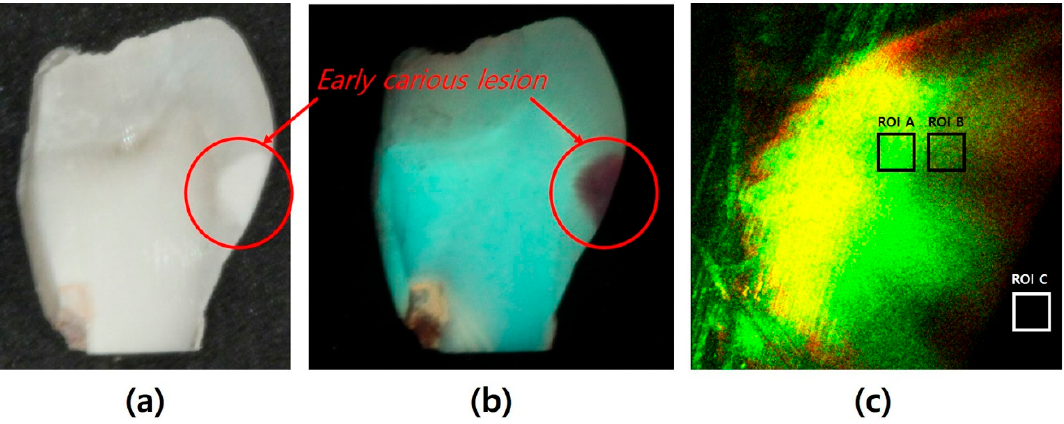
Figure 2. ( a ) White-light image of the tooth specimen obtained using quantitative light-induced fluorescence-digital system (QLF-D), ( b ) fluorescence image of the tooth specimen obtained with QLF-D, and ( c ) CLSM images of the tooth specimen showing region of interest (ROI) A (contrast-to-noise ratio (CNR), and coefficient of variation (COV) calculations), ROI B (CNR calculations), and ROI C (normalized noise power spectrum (NNPS) calculations).